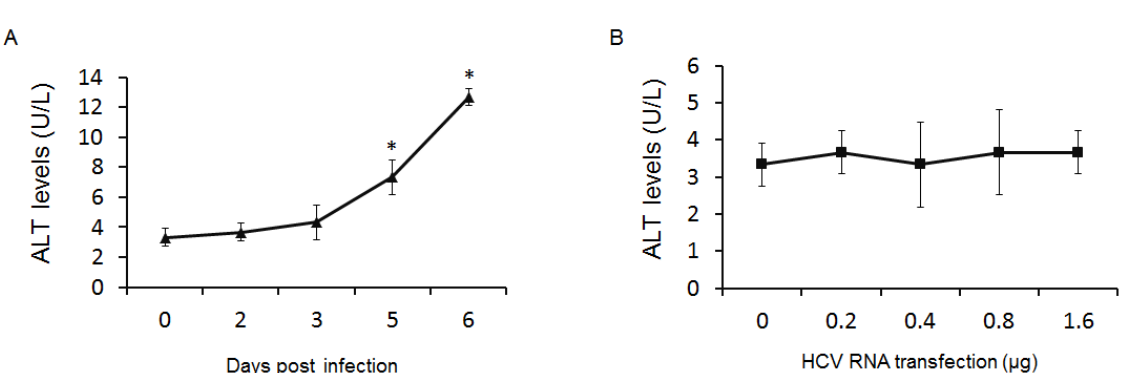
Figure 5. ALT levels in cell culture supernatant. ( A ) Huh7.5.1 cells were infected with HCV. Cell culture supernatants were collected for ALT detection at different time points after infection (* p < 0.05, compared with 0 day); and ( B ) HepG2 cells were tranfected by different dose of HCV RNA. ALT levels in supernatant were detected at 24 h post